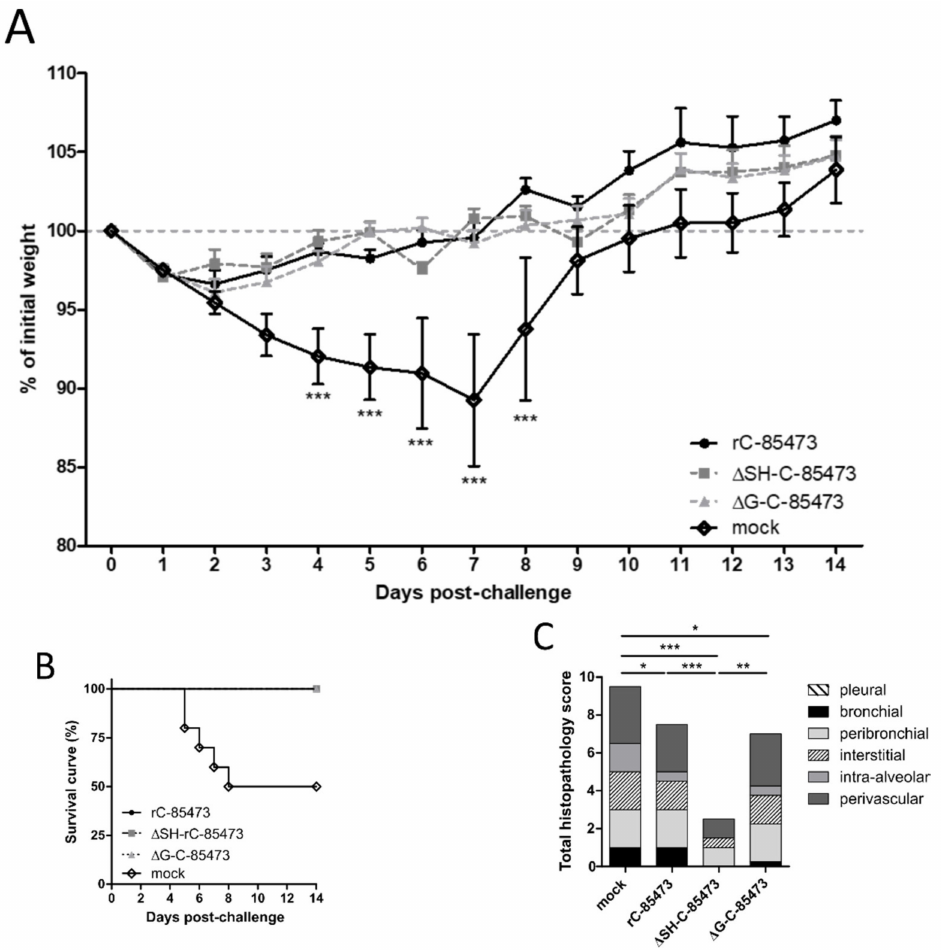
Figure 5. Weight loss, survival and histopathological scores of HMPV-immunized mice after viral challenge. BALB / c mice were intranasally immunized with 5 × 10 5 TCID 50 of ∆ SH-C-85473, ∆ G-C-85473 or WT rC85473 viruses (immunization control), as previously described. Three weeks after immunization, animals ( n = 16) were inoculated with 1 × 10 6 TCID 50 (LD 50 ) of rC-85473 (viral challenge). ( A ) Weight loss and ( B ) mortality were monitored during 14 days after the viral challenge ( n = 10). ( C ) Cumulative histopathological scores (bronchial, peribronchial, perivascular, interstitial, pleural and intra-alveolar inflammation scores) of infected mouse lungs were evaluated on day five post challenge ( n = 2) while pulmonary viral titers were measured by RT-qPCR ( n = 4, Table 2). Data are shown as means ± SEM. * p < 0.05, ** p < 0.01, *** p < 0.001 when comparing each ∆ SH / ∆ G virus to its WT counterpart using repeated measures two-way